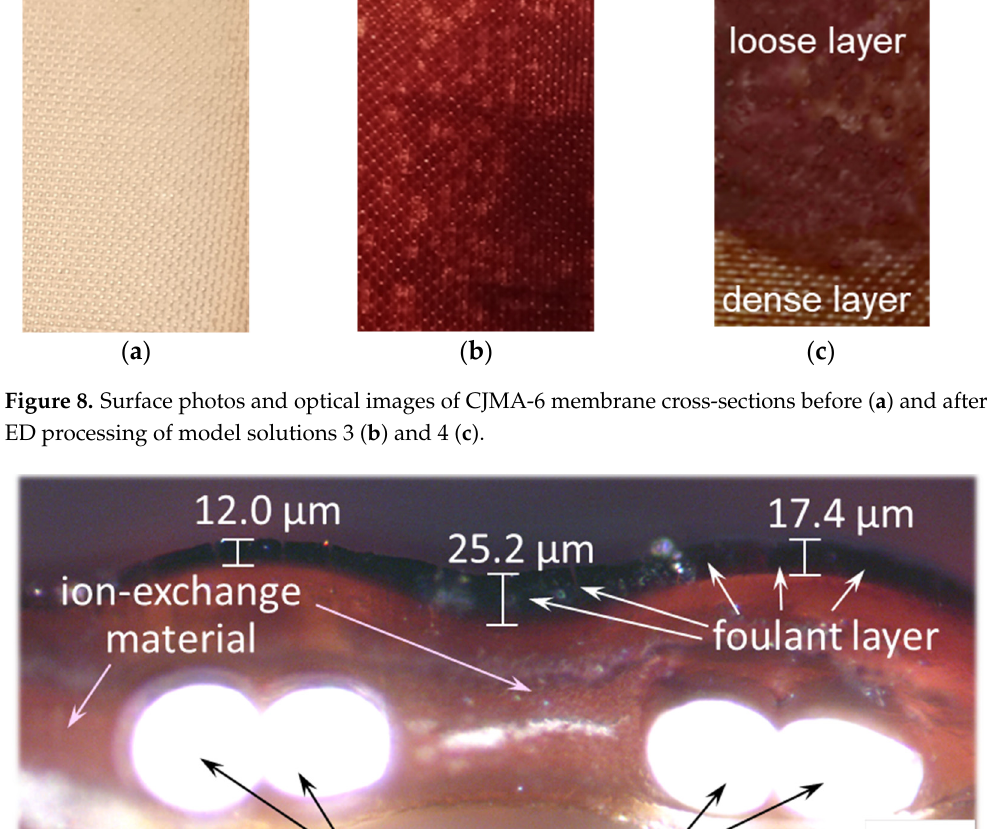
Figure 9. Optical image of a CJMA-6 membrane cross-section after ED processing of model solution 3 at a current density of 3.26 mA/cm 2 during 36 h.